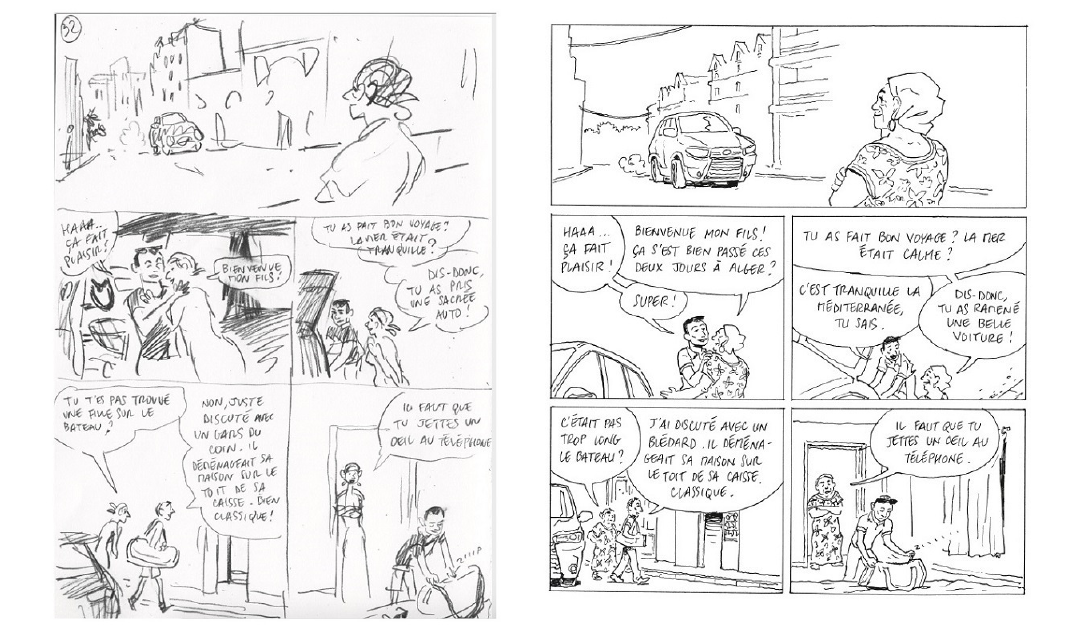
Figure 7: Vacances au bled, Bidet/Singeon